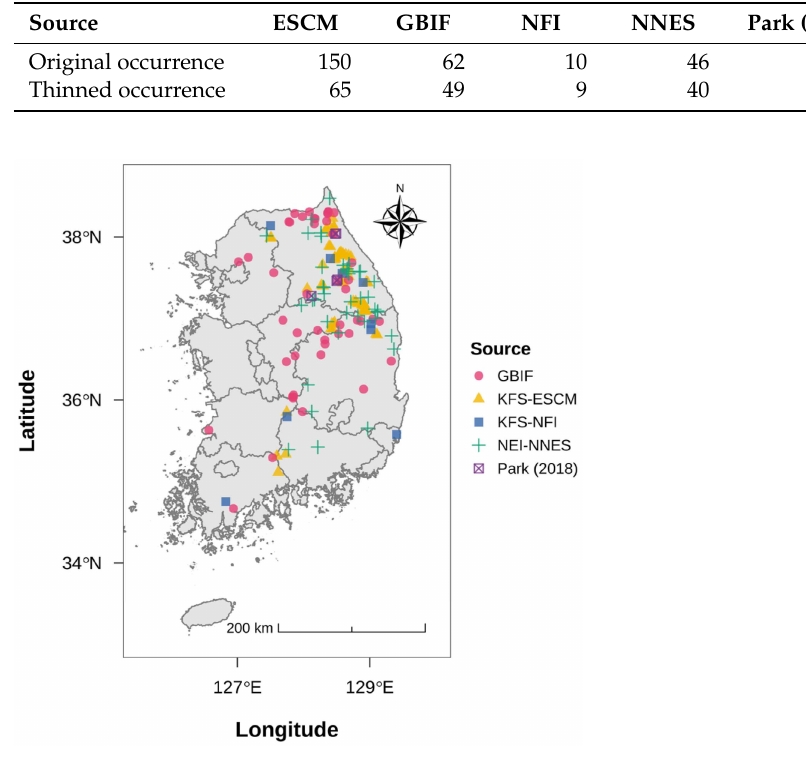
Figure 1. Locations of the thinned occurrence data for Angelica gigas